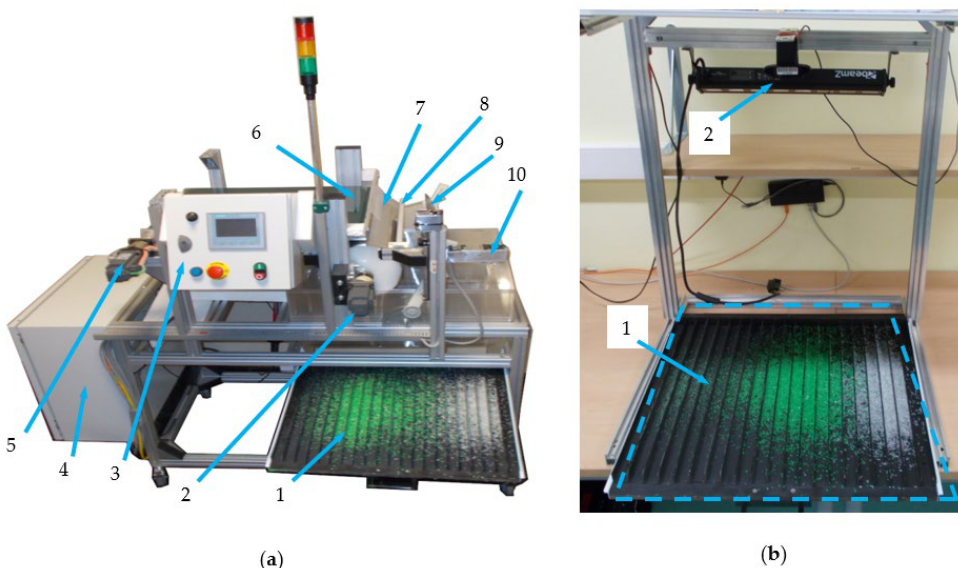
Figure 5. The view of electrostatic separator ( a ) 1-collector of material pickup (analysed material), 2-drum drive, 3-HMI control panel, 4-control cabinet, 5-feeder drive and stand for the vision system, 6-feeder, 7-drum, 8-corona electrode, 9-defecting electrode, 10-electrode positioning system, ( b ) 1-analyzed material, 2-camera.